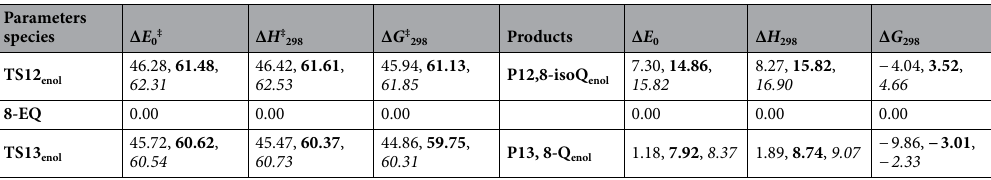
Table 2. Zero-point corrected relative energies, enthalpies, and free energies (in kcal/mol) for unimolecular decomposition for the investigated systems at different DFT/MPW1B95 (plain), M06-2X (bold) and CBS-QB3 ( italic ) methods (P = 1 atm, T = 298 K). Significant values are in bold and Italic.